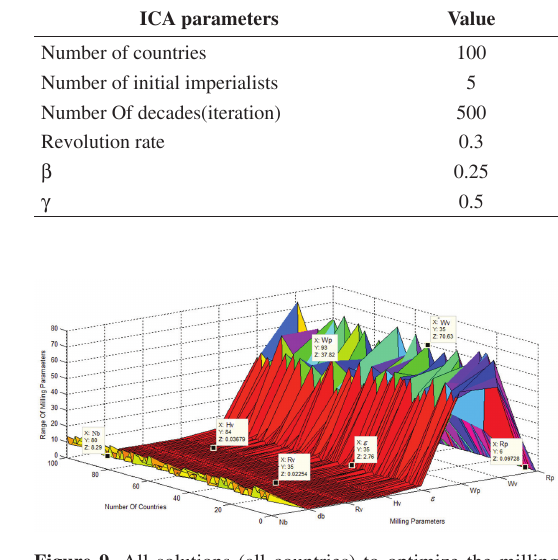
Figure 9. All solutions (all countries) to optimize the milling parameters.